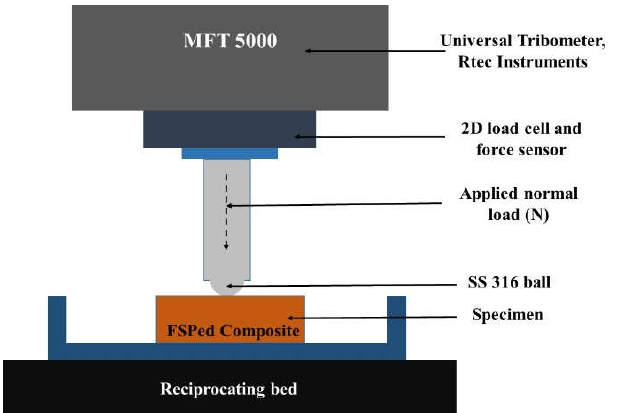
Figure 5. 2D Schematic arrangement of the ball-on-plate tribometer for the friction and wear test of Al359/Si 3 N 4 /Eggshell sample against the SS316 steel